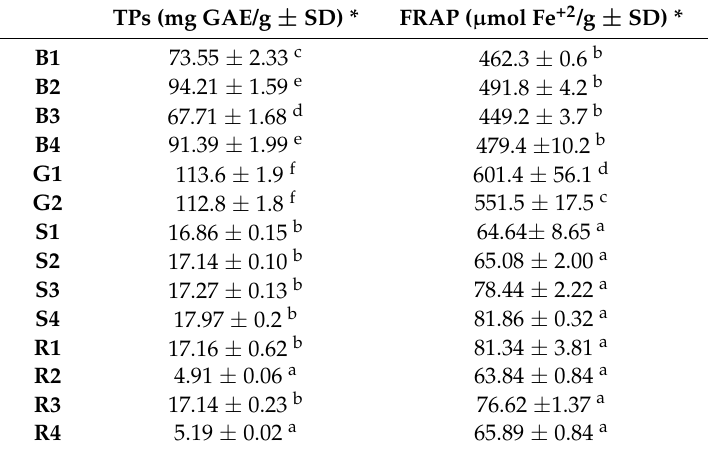
Table 2. The TPs and FRAP values of tea infusions. ( B: Black, G : Green, S : Sage, R :